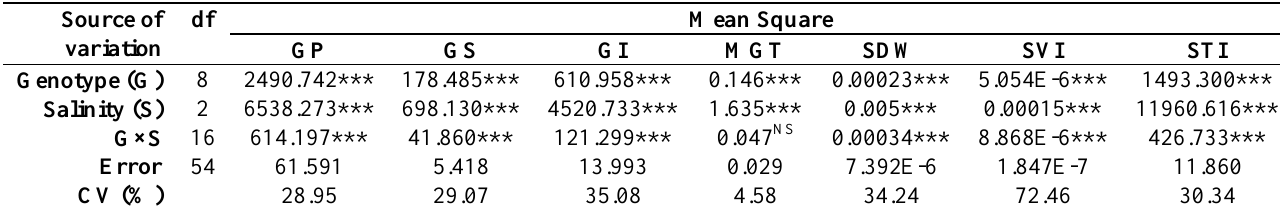
Table 1. Analysis of variance of the traits